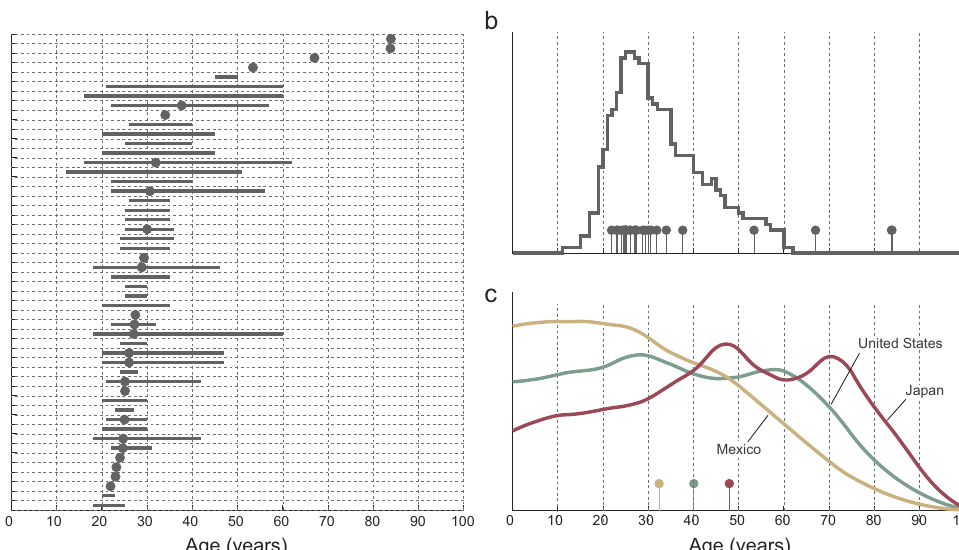
Fig. 5 Age of populations examined in the reviewed studies in contrast with the nationwide age distribution of selected countries. Panel a displays age of the population corresponding to individual studies, typically described by its range (lines) or mean (dots). Panel b displays the reconstructed age distribution in the reviewed studies (see the text). Nationwide age distributions displayed in panel c of three countries offer a stark contrast with the reconstructed distribution of study participant